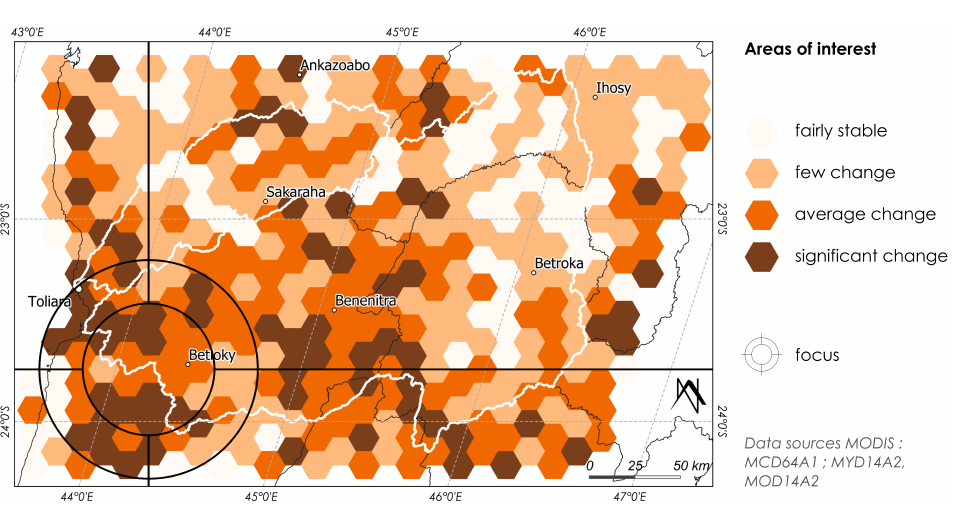
Figure 7. Cell-by-cell transformations in fire patterns 2001–2018.